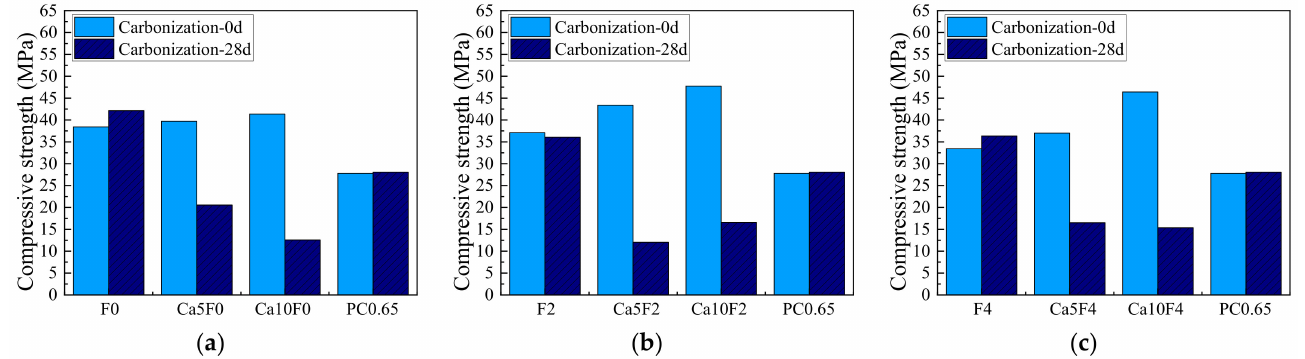
Figure 2. Compressive strength of cement and geopolymers before carbonization, and at 28 days of carbonization. ( a ) F0; ( b ) F2; ( c )